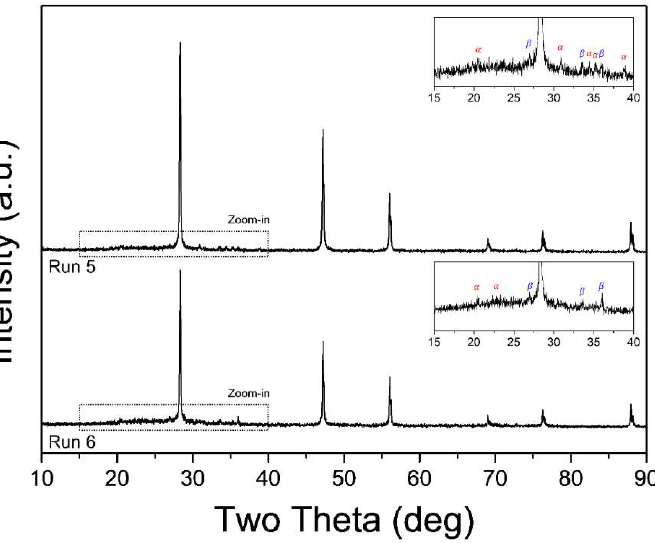
Figure 6. XRD patterns of nanopowders synthesized in Runs 5 and 6 (cone-type reaction tube with NH 3 gas addition). Inset presents an enlarged view of the graph (2 𝜃 = 10–40°).